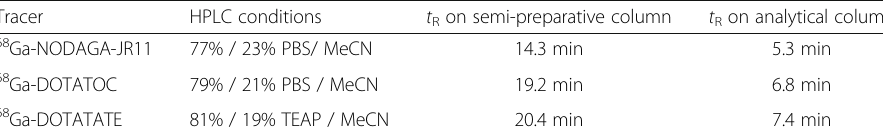
Table 1 HPLC conditions and retention times ( t R )